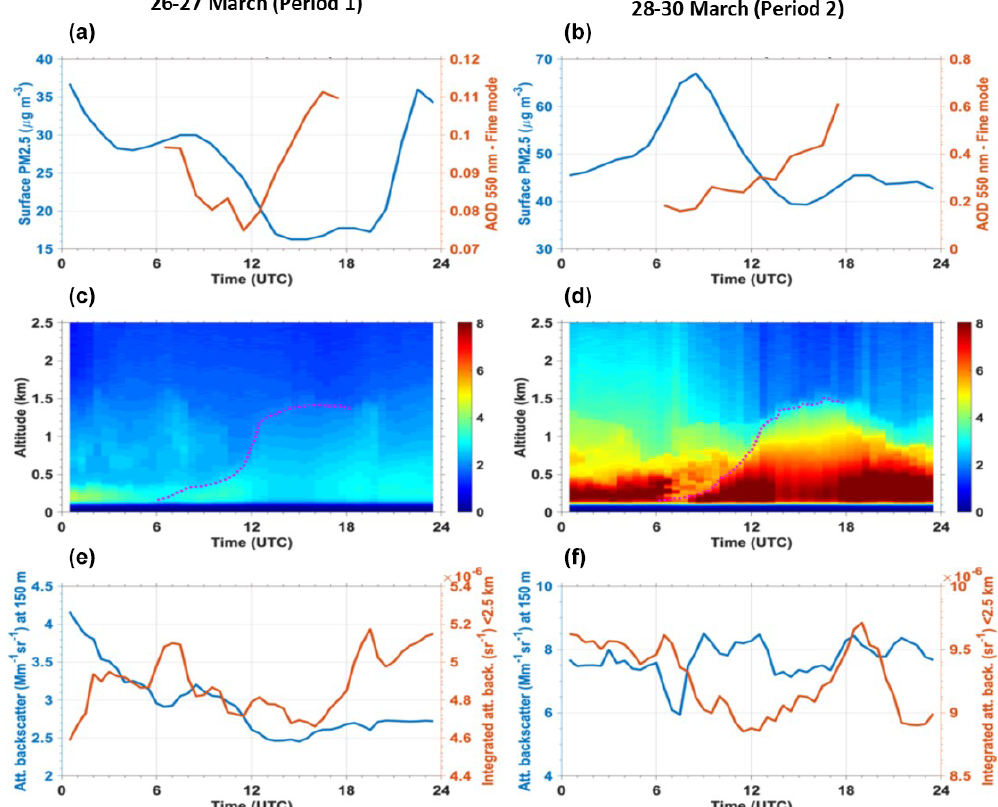
Figure 9. Median diurnal evolution of the AOD of the fine mode fraction of aerosols at 550nm at SIRTA (red lines) and surface measurements of PM 2 . 5 at Vitry (blue lines) during the periods (a) 26–27 March 2012 (P1) and (b) 28–30 March 2012 (P2). Median diurnal evolution of vertical profiles of attenuated backscatter measurements at 355nm of a ground-based lidar at SIRTA for depicting the vertical distribution of aerosols during (c) P1 and (d) P2. Dashed magenta lines in (c) and (d) show the top of the mixing boundary layer manually tracked as the lowest discontinuity of the lidar profiles during daytime (06:00–18:00UTC). Lidar-derived proxies of the diurnal evolution of particles over the total column (attenuated backscatter integrated between 0.15 and 2.5km of altitude, in red) and near the surface (attenuated backscatter at 0.15km, in blue) for (e) P1 and (f) P2. For clarity, measurements in panels (a) and (b) are shown with hourly time resolution, whereas it is 30min for panels (c–f)